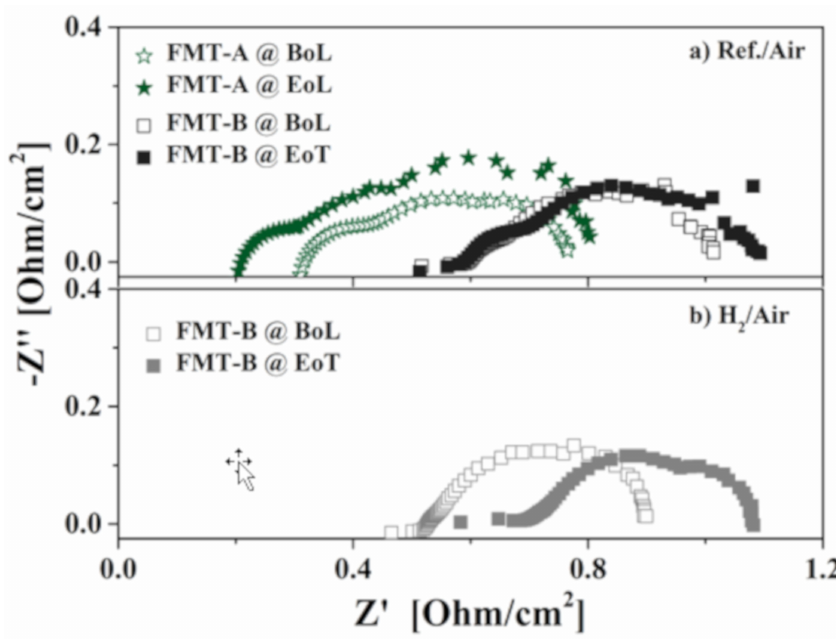
Figure 3. Nyquist plots of ( a ) FMT-A and FMT-B with fed of reformate / air ( λ = 1.5 / 2) and ( b ) FMT-B with fed of H2 / air ( λ = 1.5 / 2) operated at BoL and EoL. The cells were operated at 160 ◦ C and 1 atm under the current density of 0.3 A / cm 2 . For FMT-A EoL was 2600 h and for FMT-B EoT was 9500